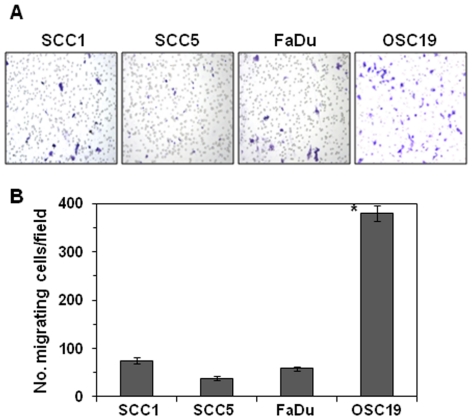
Analysis of invasive potential of HNSCC cell lines.(A) The invasion potential of several human HNSCC cell lines including SCC1 (derived from the oral cavity), SCC5 (derived from the larynx), FaDu (derived from the pharynx) and OSC19 (derived from a lymph-node metastases from the tongue) were assessed using a Boyden chamber cell invasion assay. Equal numbers of cells were loaded and after 48 h incubation, invasive cells were detected on the membrane by staining with crystal violet. (B) The invasive cells were counted and the results expressed as the mean number of invasive cells±SD/microscopic field, magnification: ×10. Significantly higher versus other cells, *
P<0.001.